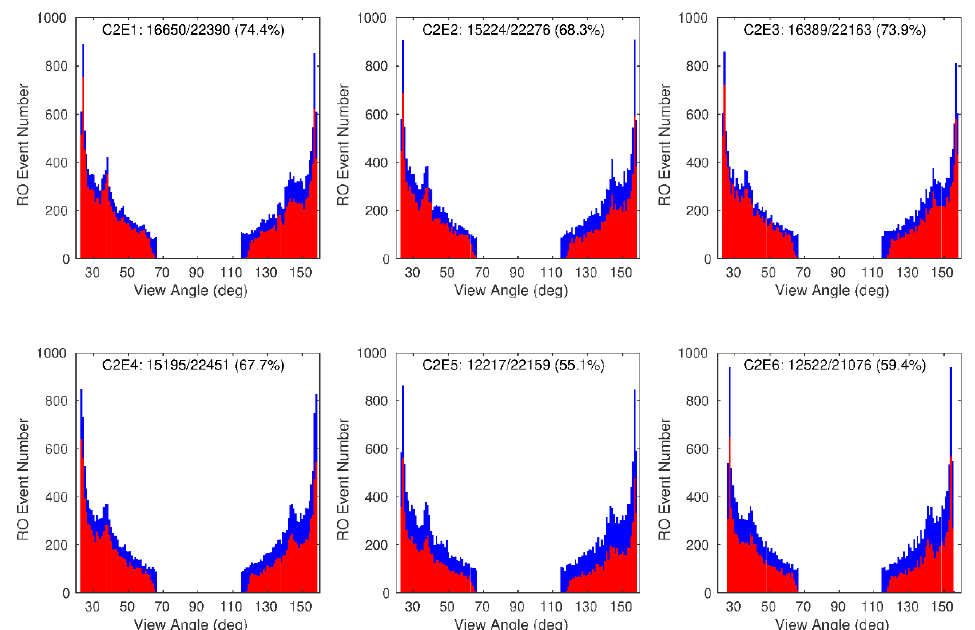
Figure 5. RO event distribution as a function of the antenna view angle for all COSMIC-2 satellite flight modules 1–6 and GPS satellites. Blue color represents predictions, and red color represents observation. The match rate for each flight module was given in the figure.